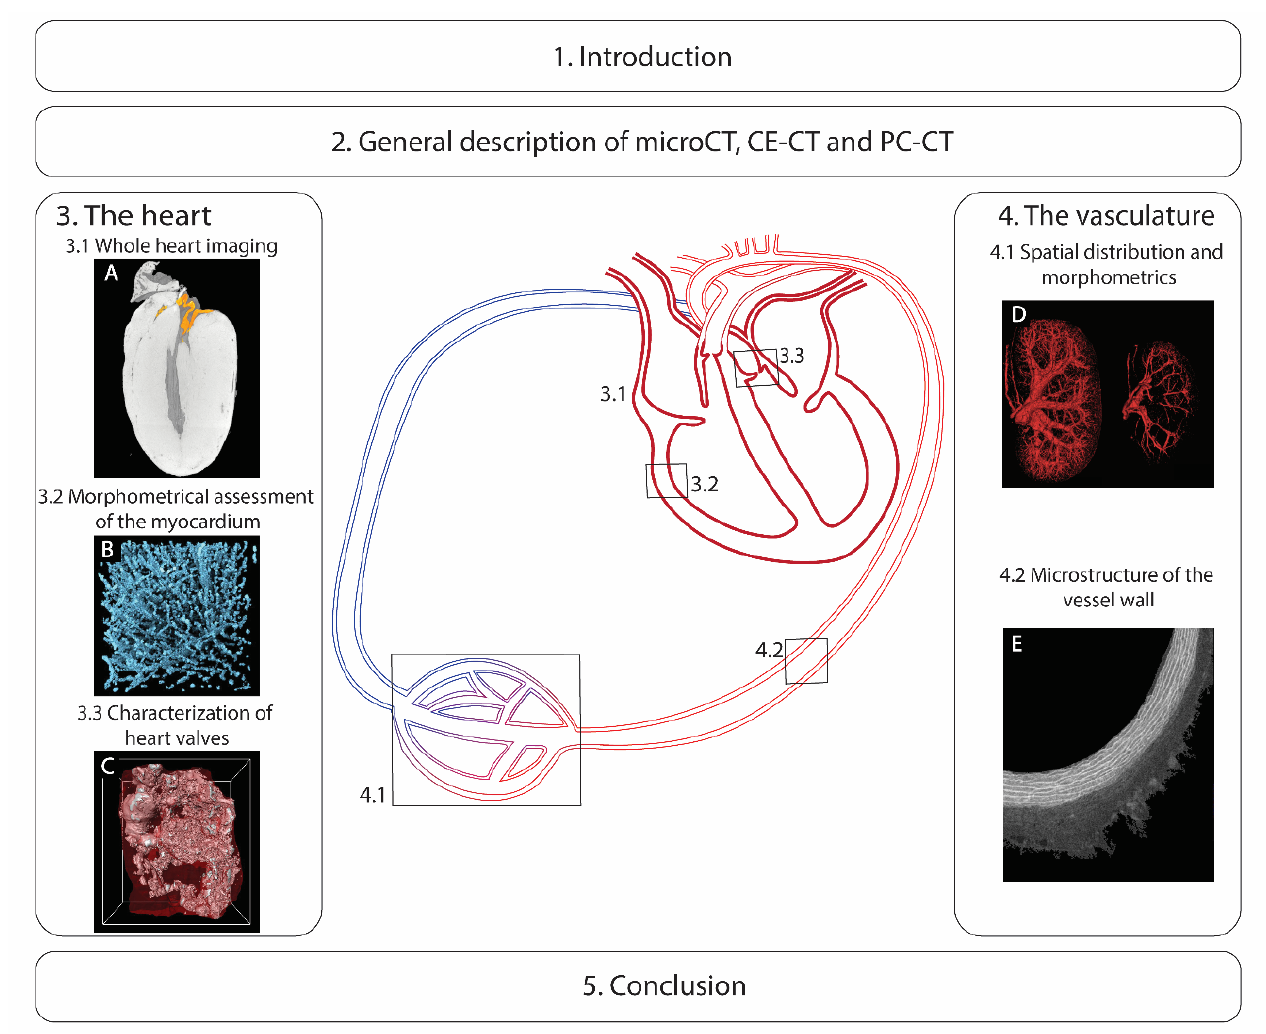
Figure 1. Schematic representation of the structure of this review. In Section 2, we provide a general description of X-ray microfocus computed tomography (microCT), contrast-enhanced microCT (CE-CT) and phase-contrast microCT (PC-CT). The third section describes the use of microCT for imaging the heart with three different parts: ( A ) the whole heart, ( B ) the morphometrical assessment of the myocardium (adapted from Reference [31]) and ( C ) the heart valves. Section 4 focuses on ( D ) the spatial distribution and morphometrics of the vasculature (adapted from Reference [5]) and ( E ) the vessel wall microstructure. We conclude with the current limitations and future perspectives.